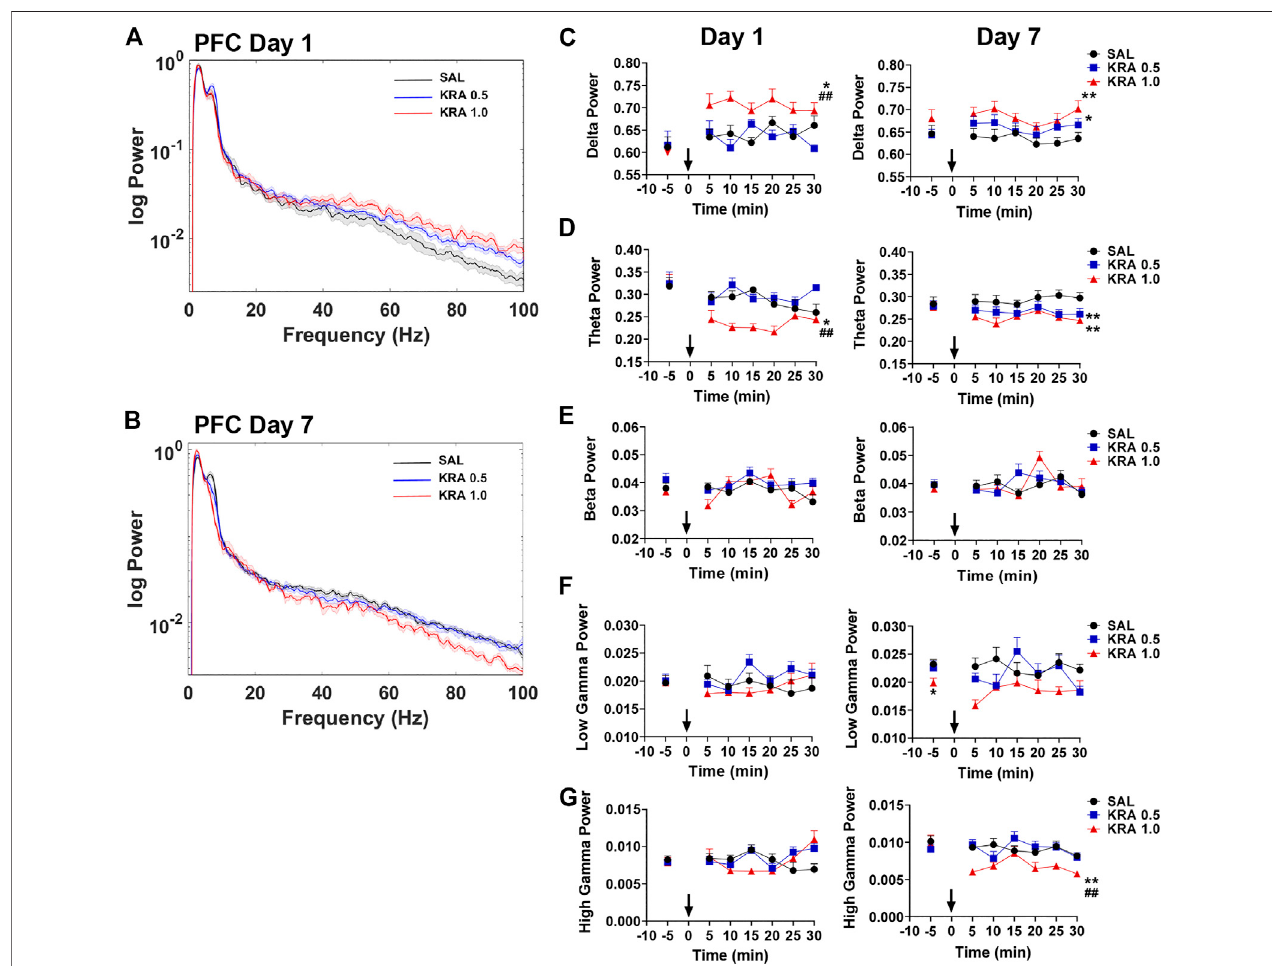
FIGURE 3 | Time course of dose-dependent effects of kratom on PFC spectral power. (A,B) Representative power spectra showing dose-dependent (0, 0.5, 1.0 mg/kg) effects of kratom 30 min post-injection on day 1 and day 7. (C) High dose kratom increased delta power on day 1 and day 7 whereas low dose kratom increased delta power on day 7. (D) Reduced theta power in response to only high dose kratom on day 1. On day 7, decreased theta power was shown in response to both dosesofkratom. (E,F) Nodrug-induced changeswereobserved inbetaorlowgammapower onday1orday 7. (G) Onday 1,kratom had noeffects onhigh gammapower.Reducedhighgammapowerwas,however,evidentonday7inresponsetohighdosekratom. N (cid:2) 7 – 10ratspergroup,with2electrodes/rat.Curvesare representedasmeans withjackknifeestimates ofsemdepicted bytheshaded areas.Bars represent mean ± sem.* p < 0.05, ** p < 0.01compared tosaline controlrats. ## p < 0.01 compared to low dose kratom treated